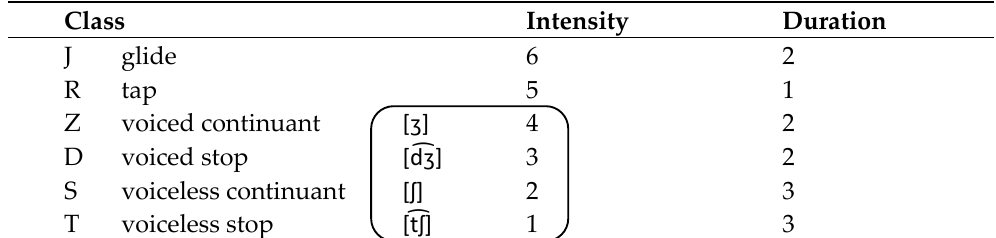
Table 3. Intensity and duration values for major consonant classes (adapted from Katz 2016, p. 57).